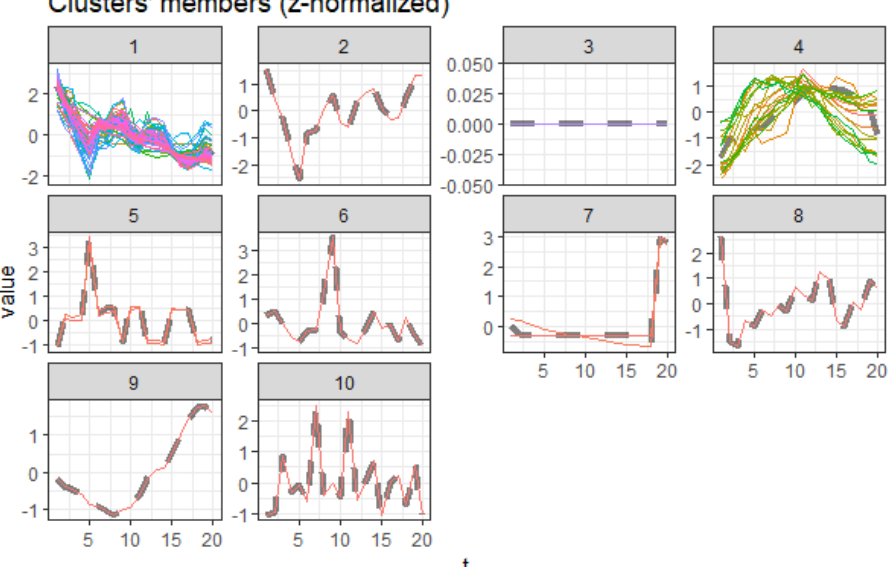
Figure 14. Centroid extractions of males aged 20 to 60.